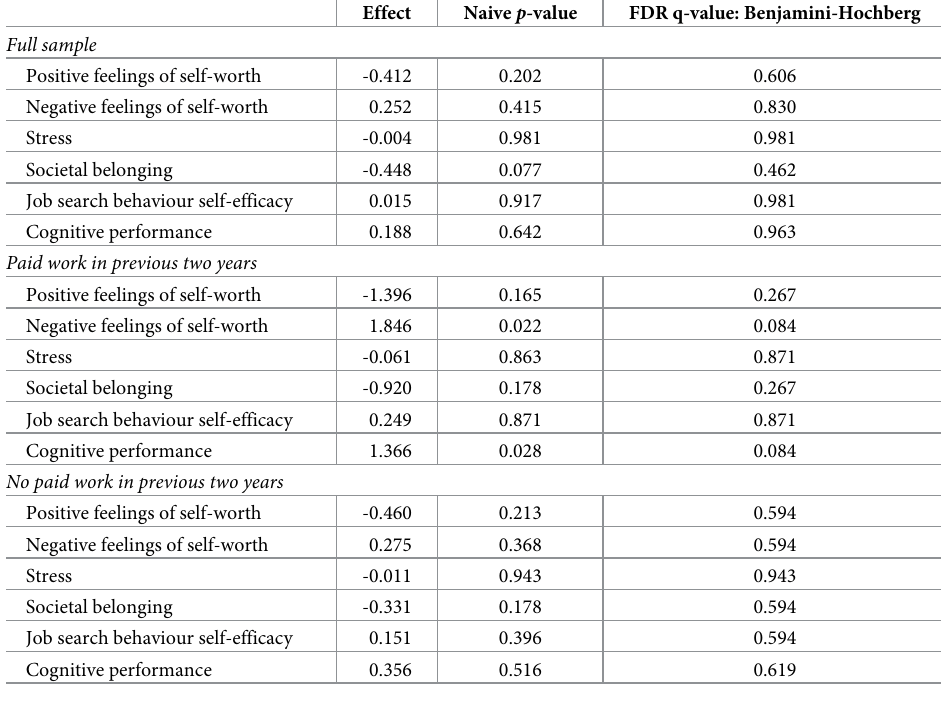
Table 2. OLS estimation results, full sample and by paid/no paid work in previous two years: Multiple inference adjustments using Benjamini-Hochberg